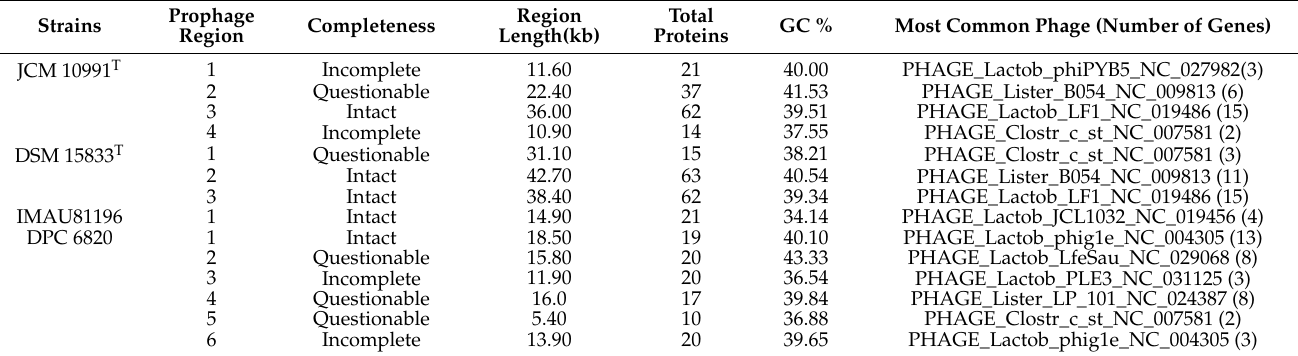
Table 3. Distribution of the prophage regions among the L. equi